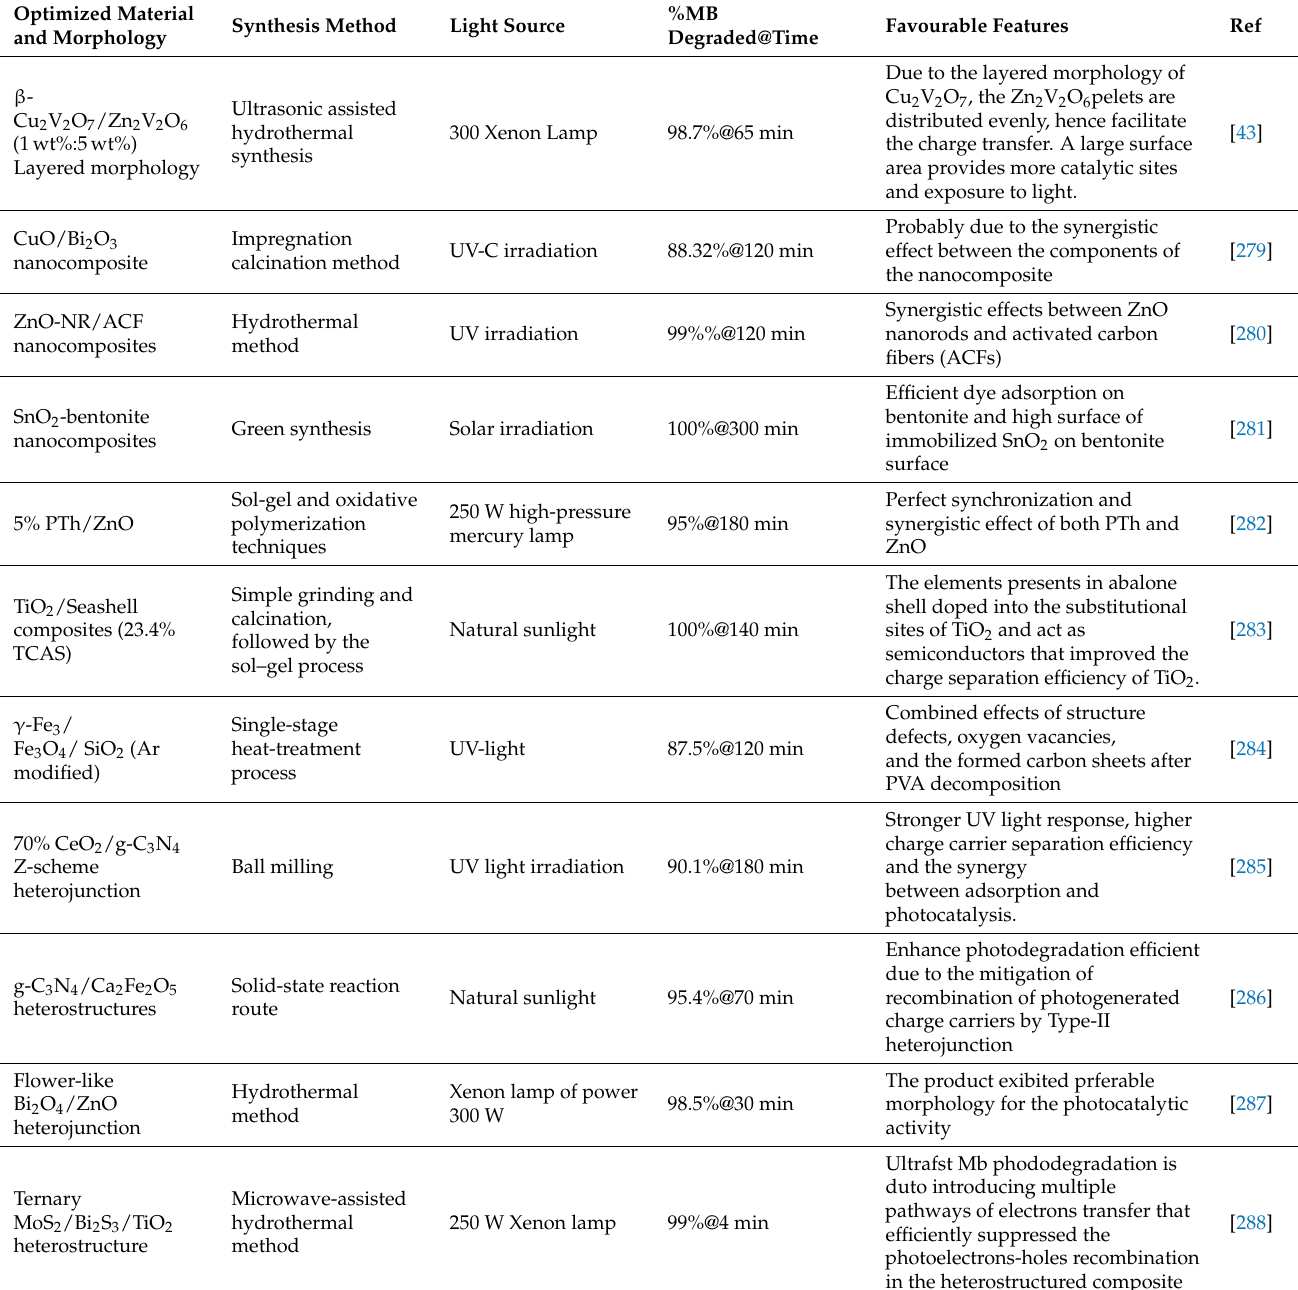
Table 3. Photodegradation of MB over various